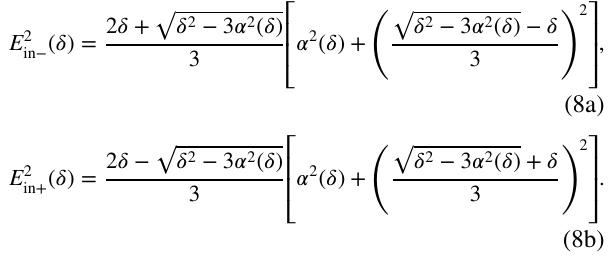
6 per round-trip. The thermal 8 J∕(s ⋅ ◦ C) 10 J∕ ◦ C , C p = 8.81 × 10 − and a ≈ 1.43 × 10 −